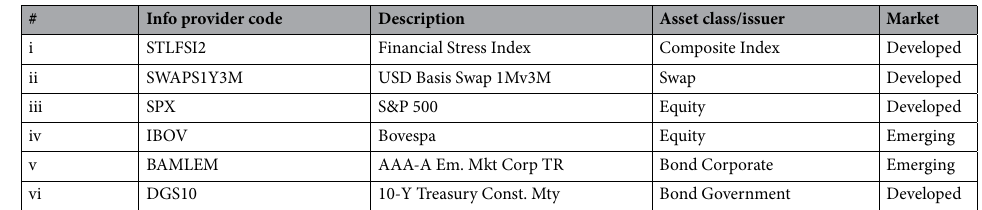
Table 2. Datasets used: (i) The Financial Stress Index STLFSI2 48 measures the degree of financial stress in the markets. It is constructed from 18 weekly data series, all of which are weekly averages of daily data series: Seven interest rates, six yield spreads, and five other indicators that each captures some aspect of financial